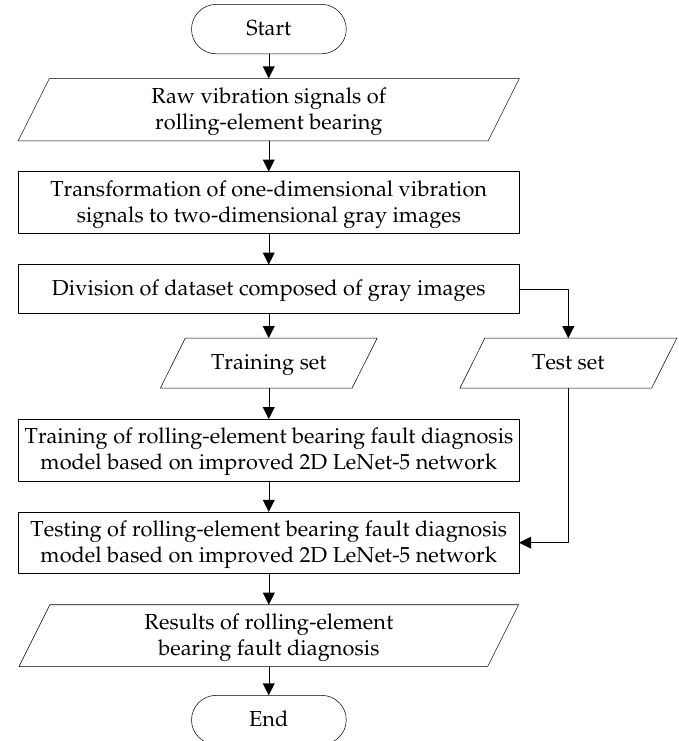
Figure 1. Flowchart of rolling-element bearing fault diagnosis based on the improved 2D LeNet-5